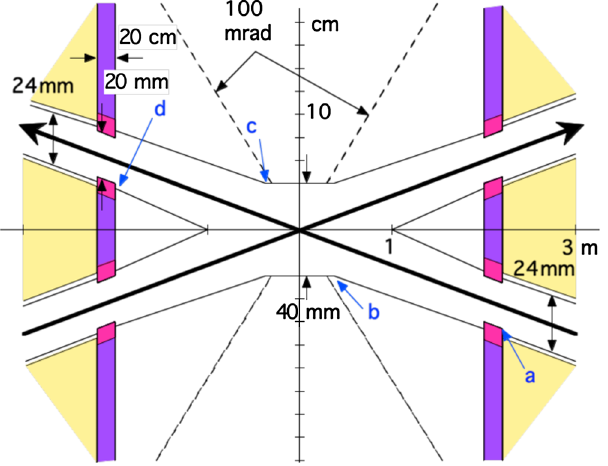
FIG. 3. Plot of the photon energy spectra for the radiation coming from the quadrupoles and the upstream bend magnet and incident on the central chamber for a 10 mm radius pipe. The histogram starts at 1 MeV. The yellow histogram is all that is left of the 100 keV critical energy radiation fan coming from the bend magnet. As one can see, the quadrupole radiation spectrum is significantly harder with some photons all the way out to 80 MeV for each beam bunch